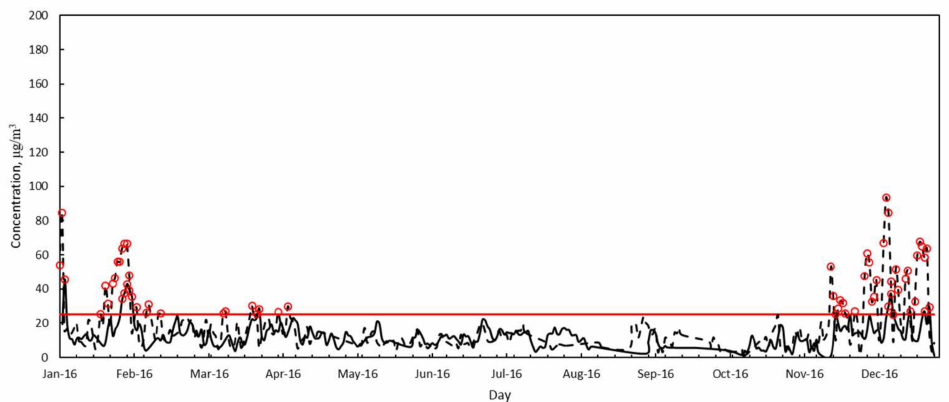
Figure 4. PM2.5 daily average concentrations measured in the HI (dashed black line) and LI (solid black line) area during 2016 from the ARPAC network. Exceedance from the law limit according to the D.Lgs. 55/2010 (solid red line) is represented by red dots.